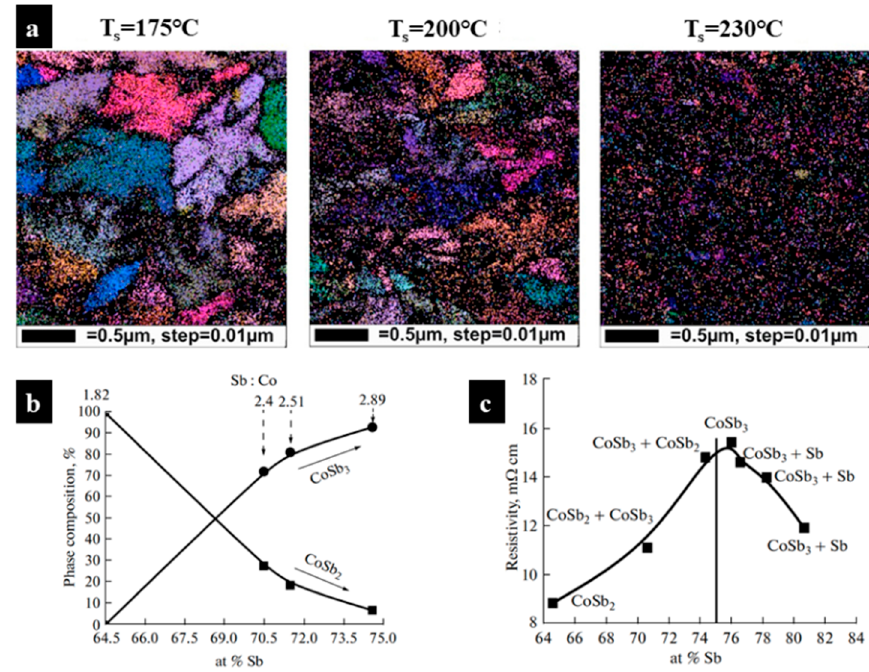
Figure 10. ( a ) EBSD analysis of CoSb 3 films at different substrate temperatures [69]; ( b ) effect of Sb content on phase composition of grown CoSb x (1.82 ≤ x ≤ 2.89) films; ( c ) Sb content dependence of resistivity for CoSb x films [71].